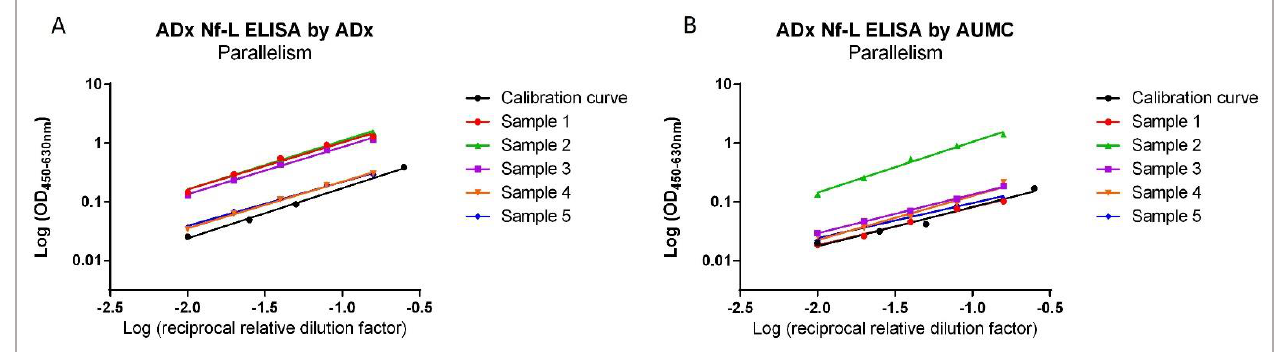
Figure 5. Parallelism. ( A ) Parallelism evaluated for five endogenous high CSF samples against the bNf-L calibrator at ADx NeuroSciences. For all five CSF samples, the percentage deviations were all within the predefined acceptable range, and, thus, the samples were parallel to the native bNf-L protein calibrator. ( B ) Parallelism evaluated for five endogenous high CSF samples against the bNf-L calibrator at AUMC. All CSF samples except one fell within the acceptable range of 80 – 120%. Table 2. Results Validation ADx Nf-L ELISA.